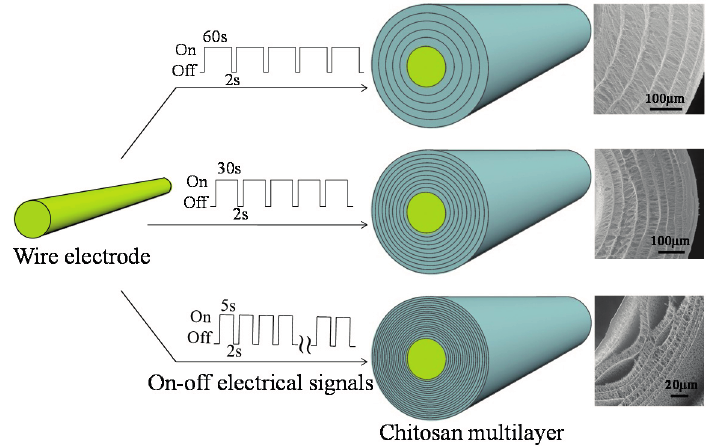
Figure 8. The structure of the electrodeposited chitosan film can be “coded” by the sequence of electrical stimuli used to induce and interrupt chitosan’s cathodic electrodeposition. Adapted from Yan et al.